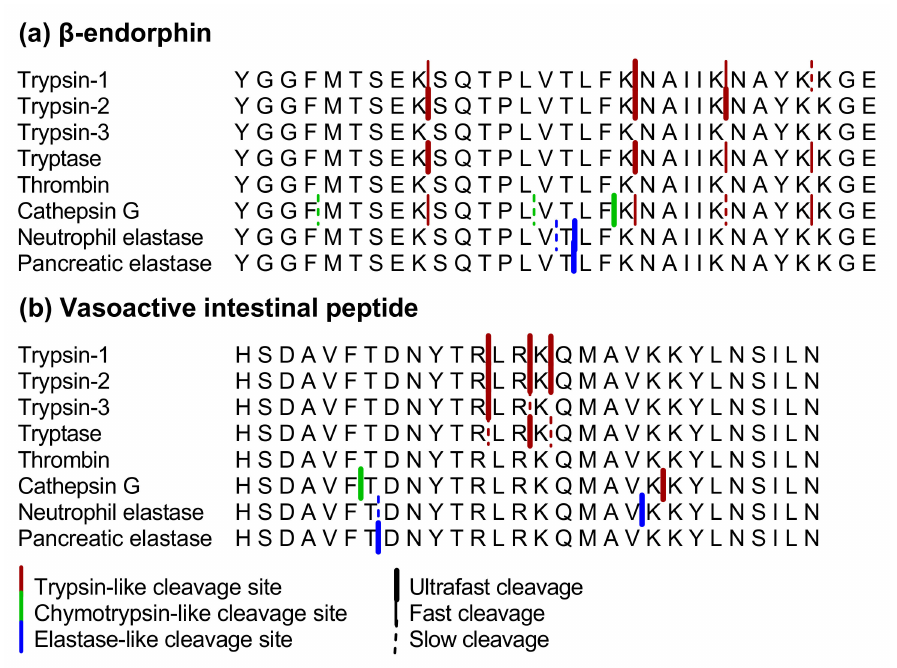
Figure 1. Cleavage sites in ( a ) β -endorphin and ( b ) VIP after incubation with trypsin-1, trypsin-2, trypsin-3, tryptase, thrombin, cathepsin G, neutrophil elastase or pancreatic elastase. Trypsin-like cleavage sites are shown in red, chymotrypsin-like cleavage sites are in green and elastase-like cleavage sites are in blue. Thick lines indicate ultrafast cleavages (within two min of incubation), thin lines indicate fast cleavages (after 5 min of incubation) and dotted lines indicate slow cleavages (after 10 or 30 min of